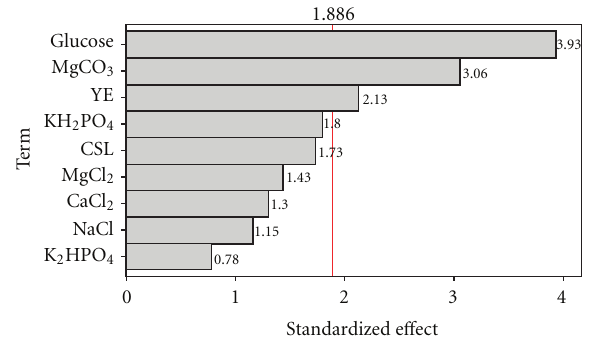
Figure 1: Pareto chart of standardized e ff ects on the succinic acid production. The chart includes a vertical line (i.e., standardized e ff ect = 1.886) at the critical t -value for α of 0.20. The bars are displayed in order of the size of the e ff ects, and the standardized e ff ect of each term was shown on the top of its corresponding bar. significant and not a ff ecting the response variables. E ff ects may be positive or